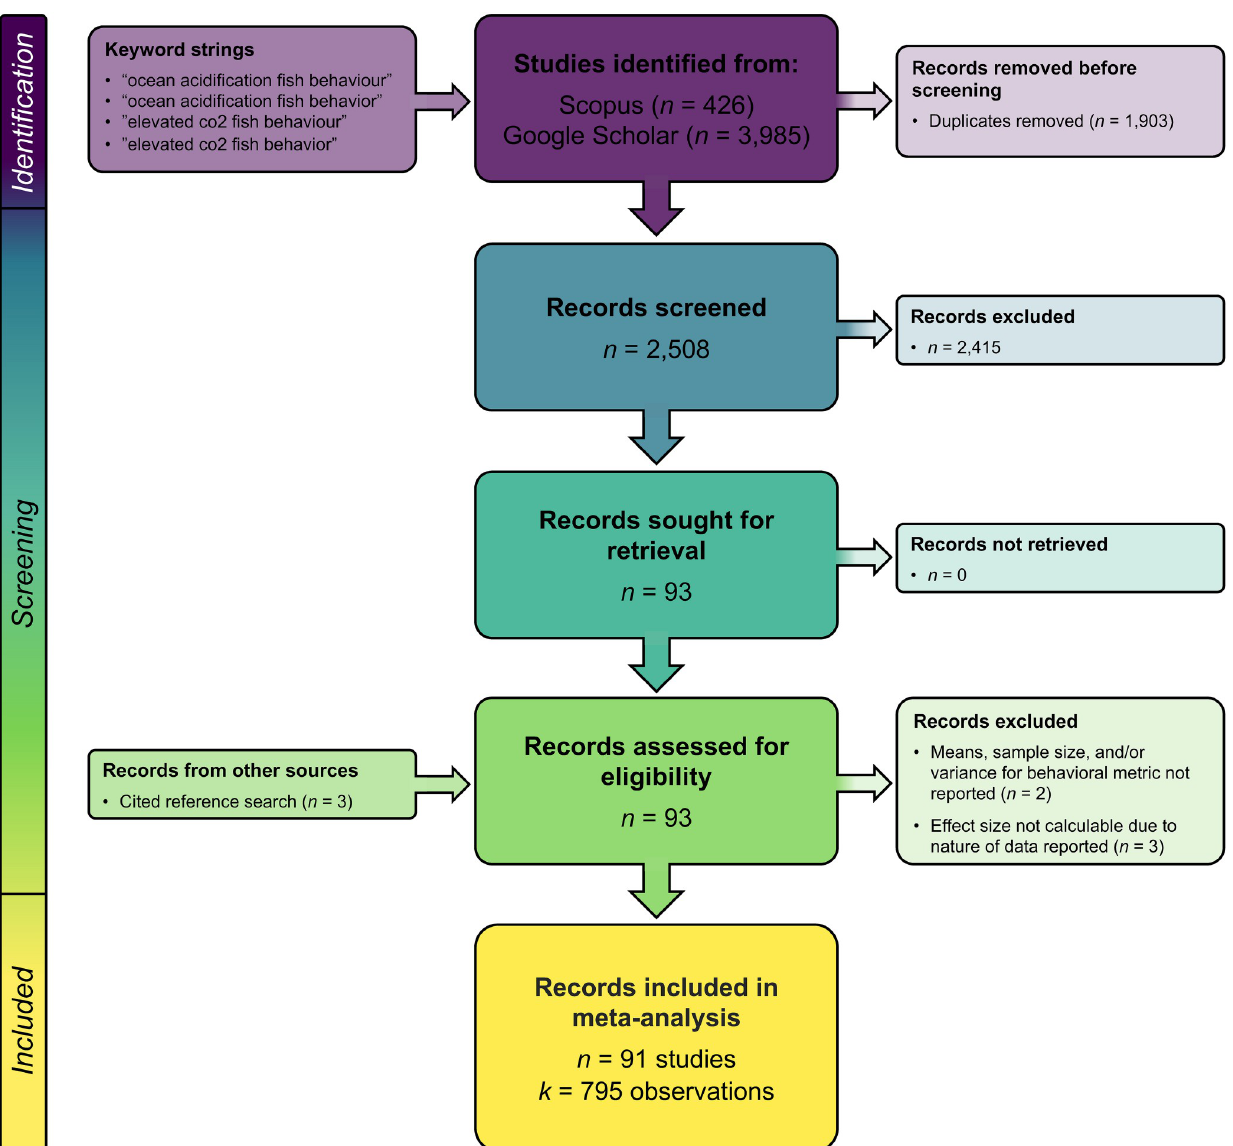
Fig 6. PRISMA flow diagram. Values represent the numbers of records found and retained at each stage of the literature search. Papers were considered “relevant” if they included an empirical test of ocean acidification on the behavior of a marine fish. Off-topic papers and topical review papers were excluded, as were topical papers on freshwater species and invertebrates. Relevant studies were deemed “ineligible” if they did not contain data from which effect sizes could be calculated (this included data that did not have an associated sample size or variance or relevant papers that did not report the behavioral data). Details of relevance and exclusion can be found in S4 Data. PRISMA, Preferred Reporting Items for Systematic Reviews and Meta-